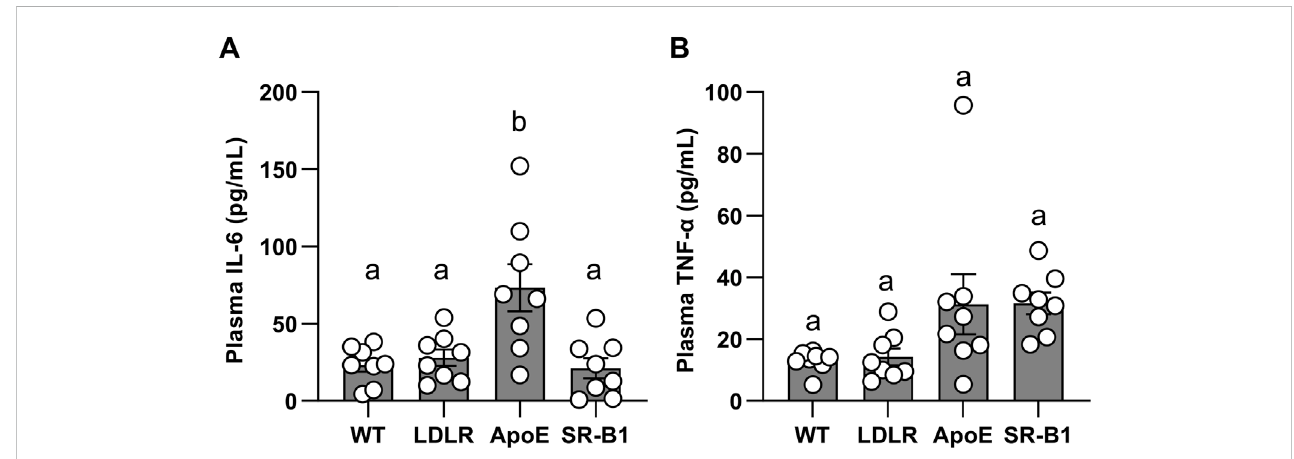
FIGURE 5 Levels of circulating IL-6 and TNF- α in plasma. IL-6 (A) and TNF- α (B) were measured by ELISA in plasma from female mice after 20 weeks of HFCC feeding. Individual symbols represent samples from individual mice and bars with error bars represent average ± SEM of N = 8 per group. Different letters indicate statistically signi fi cant differences from one another by one-way ANOVA with Tukey ’ s post-hoc test. (A) Overall ANOVA: p = 0.0008; multiple comparisons: p < 0.01 for a vs. b. (B) Overall ANOVA: p = 0.02; multiple comparisons: p > 0.05 (not statistically signi fi cant) for each comparison.